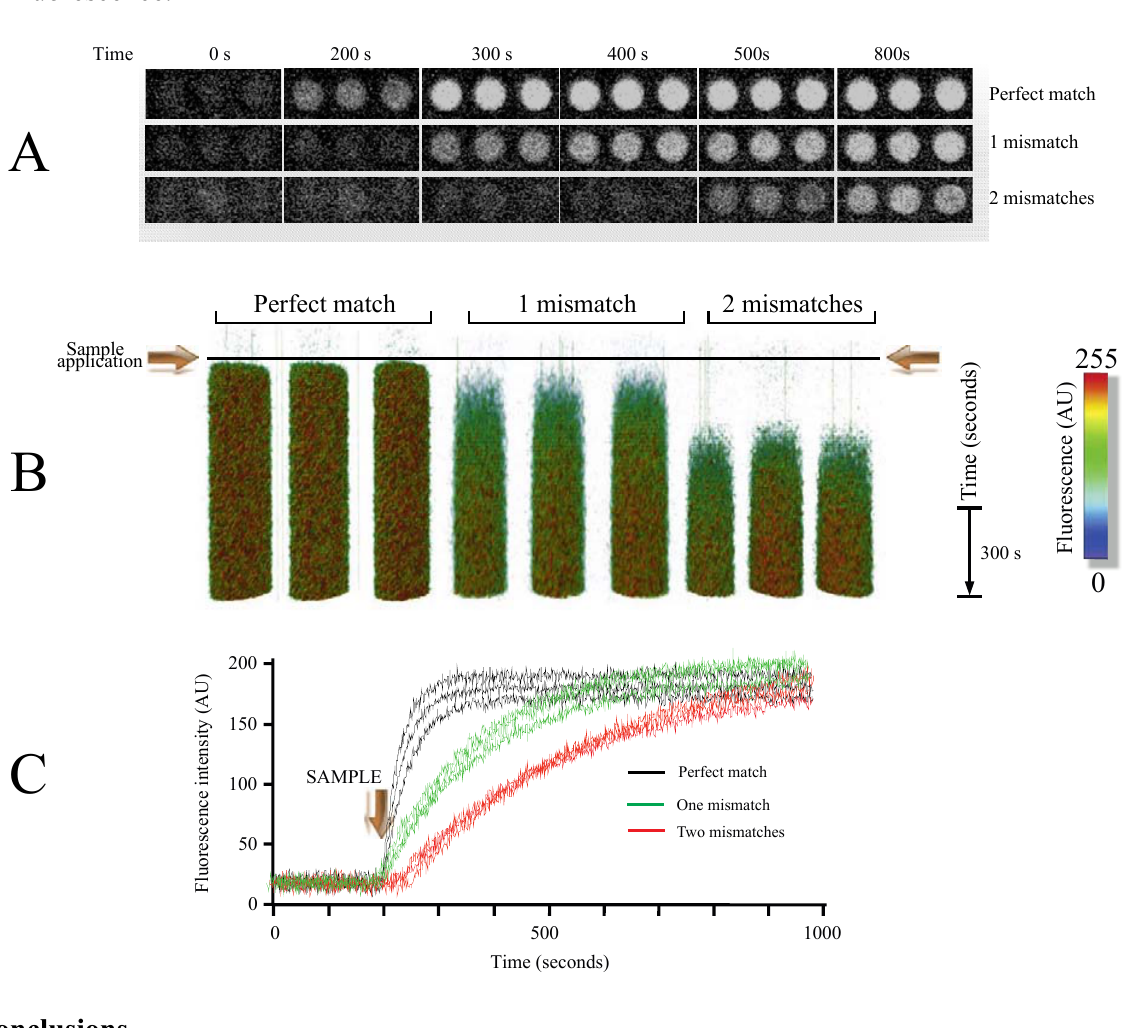
Figure 4. Identifying mismatches based on association kinetics from the micorarray. ( A ) Images obtained at different time points illustrating increments in fluorescence upon addition of three samples (DNA for pag ). Samples are: perfect match to MB1, sample with one mismatch and sample with two mismatches (see Experimemtal Section for sequences). ( B ) Tridimensional rendering plot illustrating the entire microarray experiment time course in one image. This is a volumetric image plotting the changes in fluorescence overtime of each spot in 3D (x-y versus time). Pseudo-color was utilized to enhance even the smallest increment in fluorescence, making it easier to identify. The triplicate spots for perfect match, one and two mismatches are illustrated. ( C ) Time courses showing changes in mean fluorescence of each spot as lines overtime for perfect match (black lines), one mismatch (green lines) and two mismatches (red lines). Each line represents the mean fluorescence of one spot over time. Notice that the more mismatches present, the slower the increment in